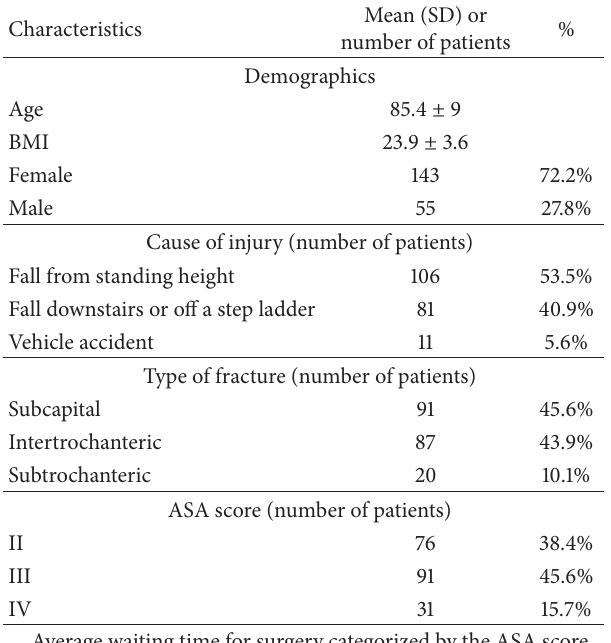
Table 1: Characteristics of hip fracture cohort ( 𝑛 = 198